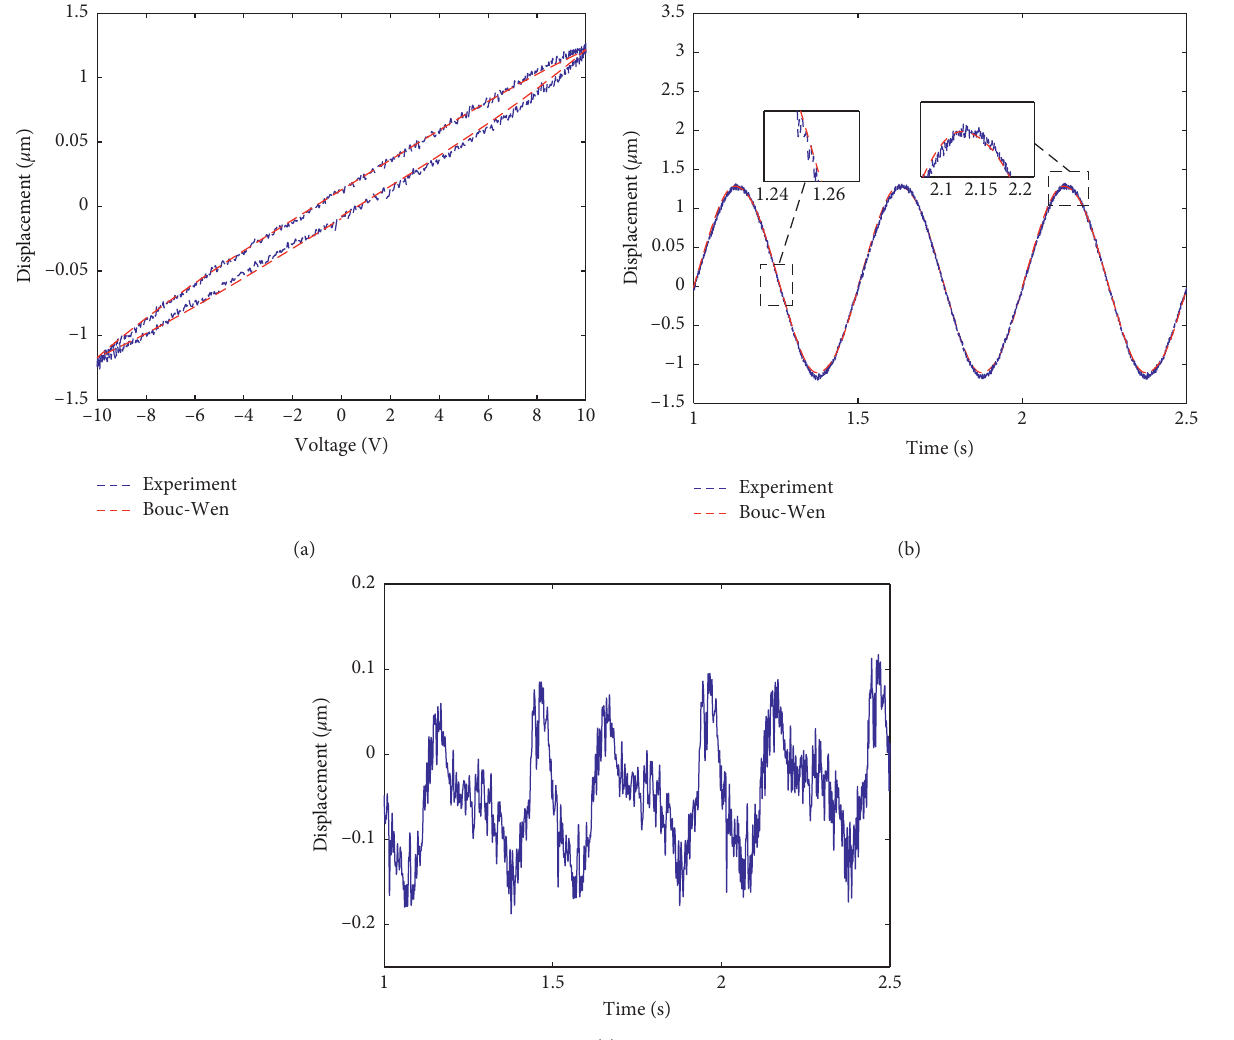
Figure 10: X -direction identification results. (a) Comparison between the hysteresis model and the experimental data. (b) Displacement tracking of the hysteresis model. (c) Tracking error in the X